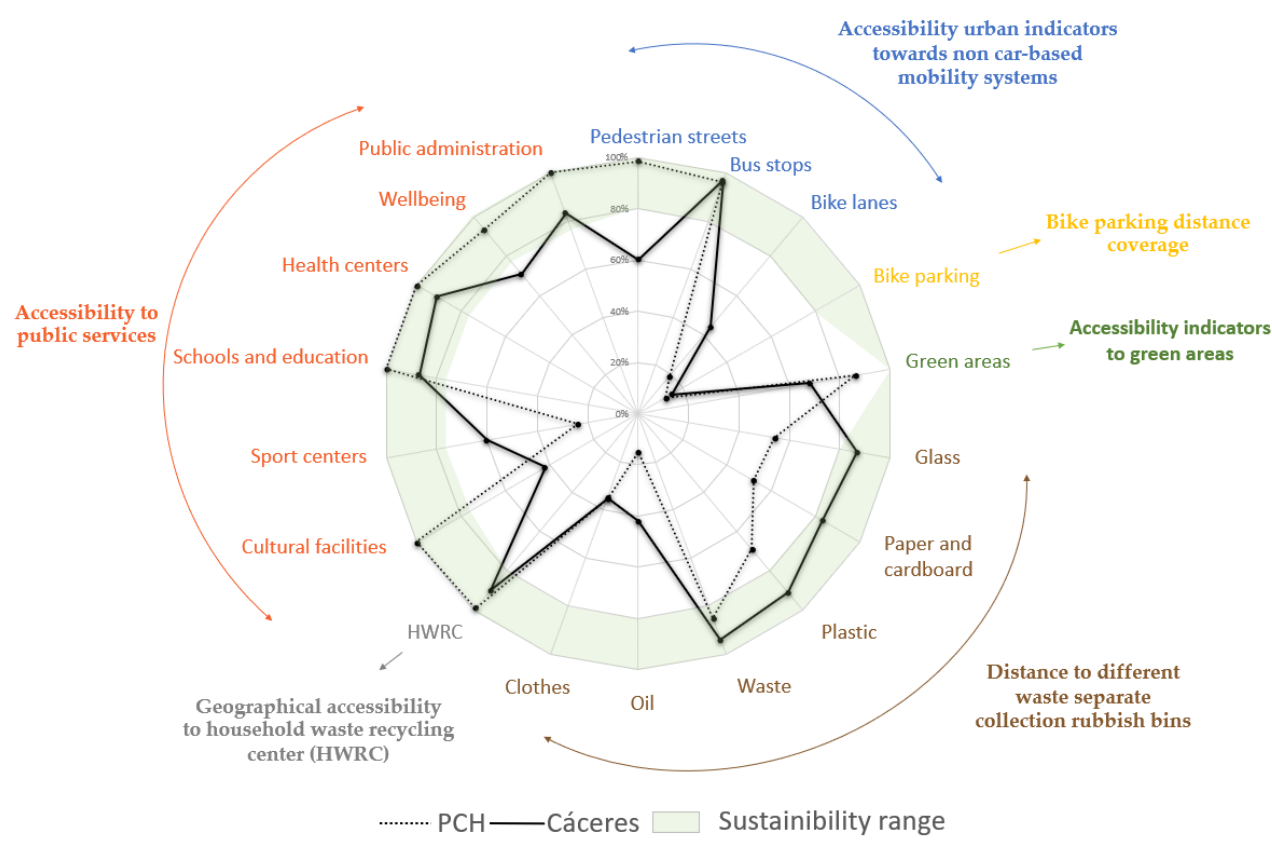
Figure 10. Spider web diagram summarising the numerical results of the sustainability analysis in the city of Cáceres.